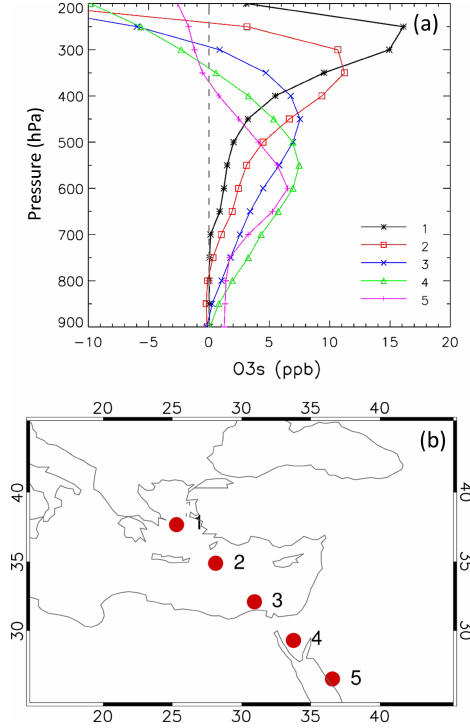
Figure 7. Vertical profiles of the anomalies of EMAC-simulated O 3 s during the selected fold events with respect to the rest of sum- mer time steps (a) for five grid points in a northwest direction over the EMME region (b) .